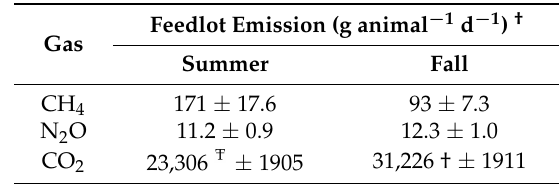
Table 2. Daily gas emissions ( ± standard error) from the feedlot (g per animal) for a growing crop (June/July) and a tilled stubble surface